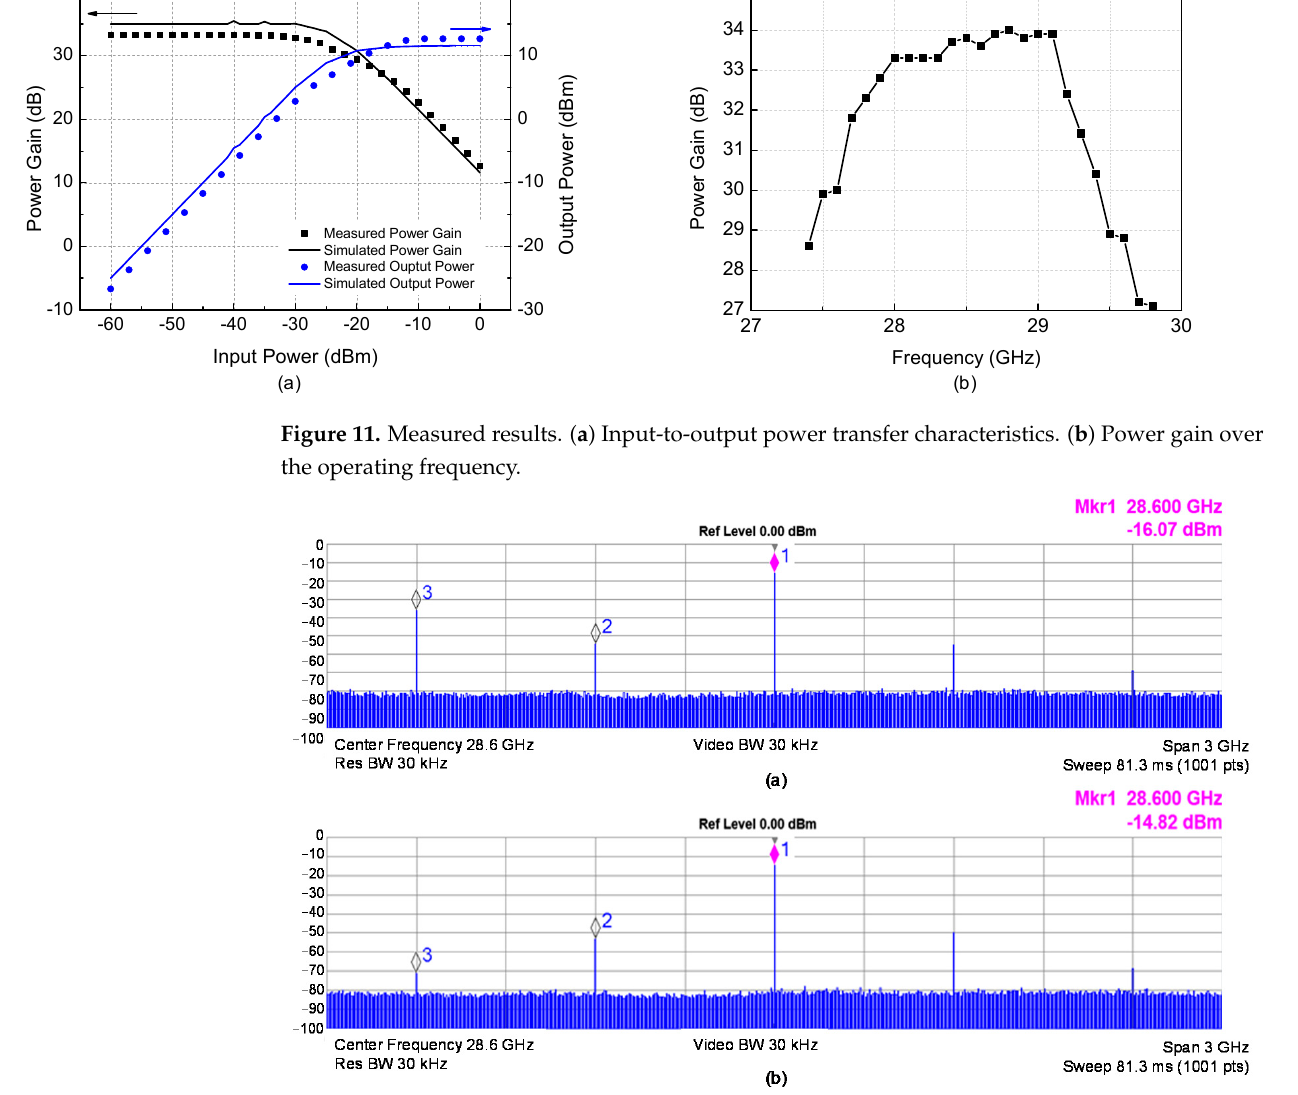
Figure 12. Measured output spectrum ( a ) before calibration and ( b ) after calibration.